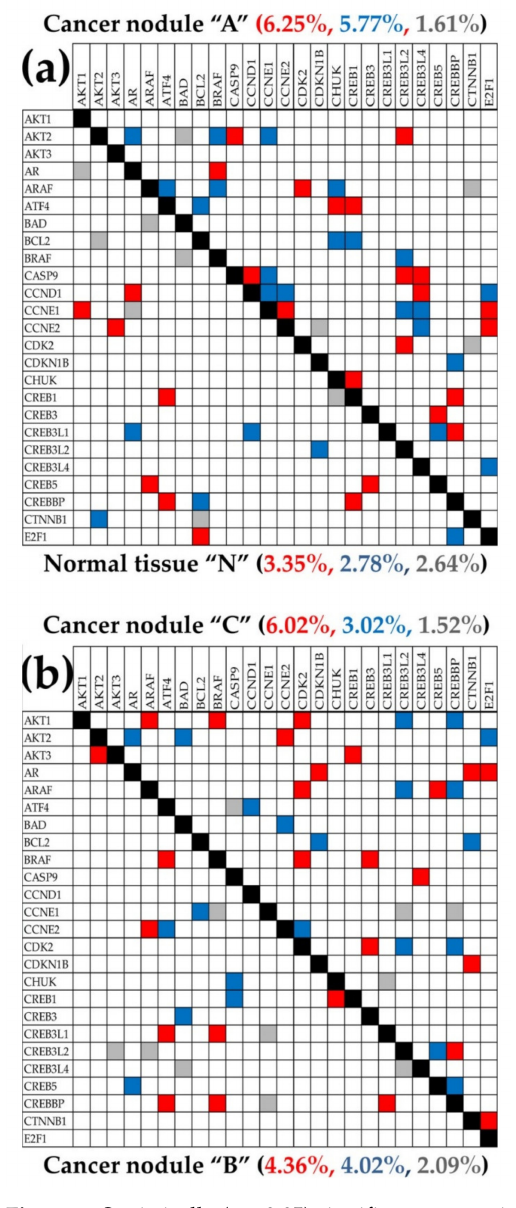
Figure 5. Statistically ( p < 0.05) significant expression synergism, antagonism, and independence of the first 25 alphabetically ordered KEGG-identified prostate cancer-related genes in the normal